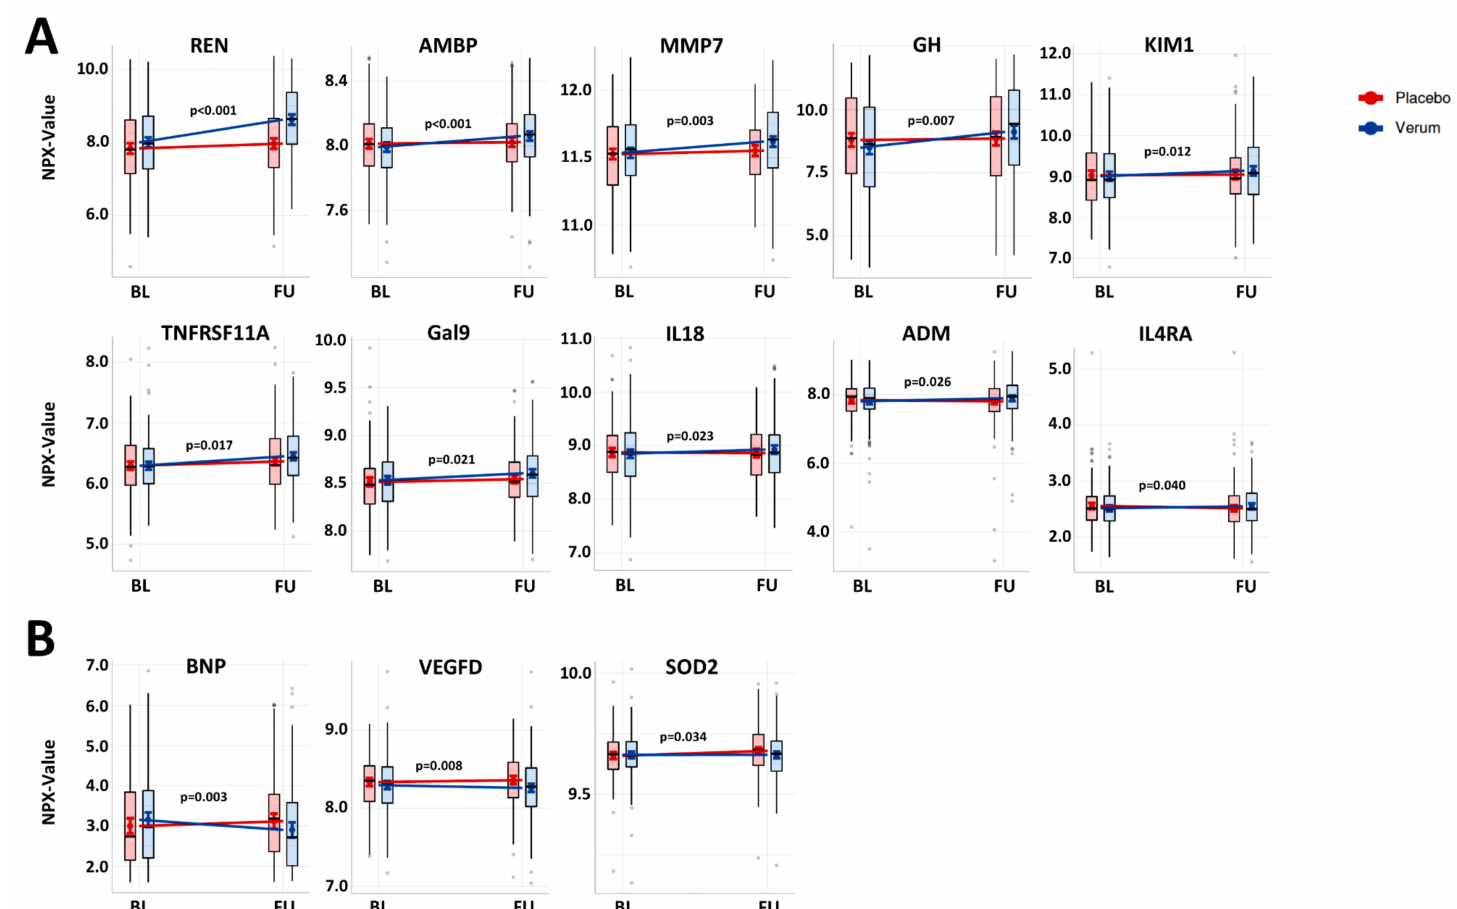
Figure 2. Effect of spironolactone treatment on differential regulation of plasma biomarkers in HFpEF. ( A , B ): Plasma biomarkers with significantly increased ( A ) or decreased ( B ) expression levels from baseline (BL) to twelve-month follow-up (FU) following spironolactone treatment (verum) vs. placebo control are shown (corrected for age and sex). The modelled effects are illustrated as expected marginal means with 95% CIs. The semi-transparent boxplots show the median (centre line) and the lower and the upper quartile (box) of the originally measured NPX values; the whiskers extend to the minimum/maximum, but are capped at a distance of 1.5 times the interquartile range above the upper/lower quartile. p -values of the interactions from linear mixed effect models are reported in the respective